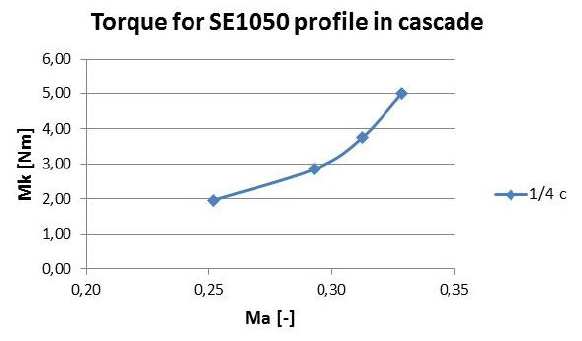
Fig. 8. The torque dependency on inlet Mach number for SE1050 three-blade cascade, measured for centre blade.